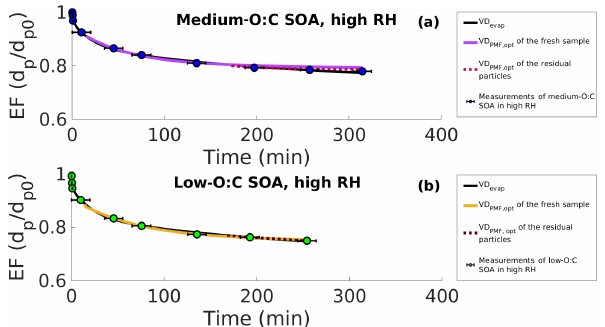
Figure 5. Evapograms of high-RH experiments showing the evapo- ration factors (circles), their uncertainty in time (black whiskers), the best-fit simulated evapogram calculated with VD evap (solid black line) and the best-fit simulated evapograms calculated with the volatility distribution, where the effective saturation concen- tration (C ∗ ) of each of the PMF factors is fitted to the measure- ments (VD PMF , opt ). (a) Medium-O : C SOA. (b) Low-O : C SOA. The solid colored lines are for the fresh SOA, and the dashed lines are for the residual particles collected from the RTC after 173–259 and 168–254min of evaporation for medium- and low-O : C SOAs, respectively. For fitting, the C ∗ of each PMF factor was allowed val- ues from their respective 25th and 75th percentile desorption tem- peratures, as shown in Fig. 1. All the evapograms calculated with the VD PMF , opt match the measured evaporation, highlighting that the volatility distribution determined from the FIGAERO–CIMS data with the PMF method can describe the dynamics of evapo- rating SOA particles when uncertainties in the C ∗ of the factors are